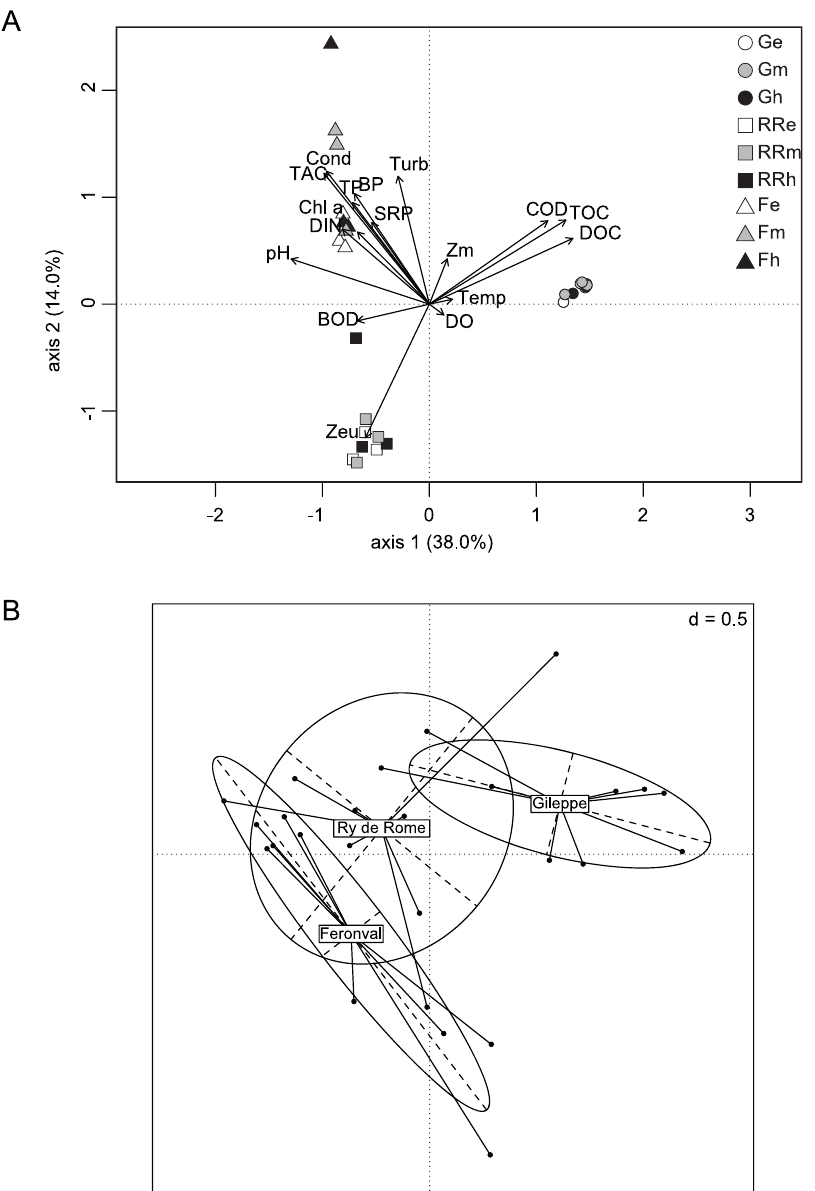
Fig. 6. Canonical and Factorial correlation analyses. Canonical correlation analyses ( A ) and factorial correspondence analysis ( B ) of bacterial communities based on relative abundance at OTU level (0.03 cut- off) and environmental parameters in the analysed reservoirs and all sampling dates. Legend: G, La Gileppe (dots); RR, Ry de Rome (square); F, Fe´ronval (triangles); e, epilimnion (white); m, metalimnion (grey); h, hypolimnion (black); 04, April 2010; 07, July 2010; 10, October 2010.